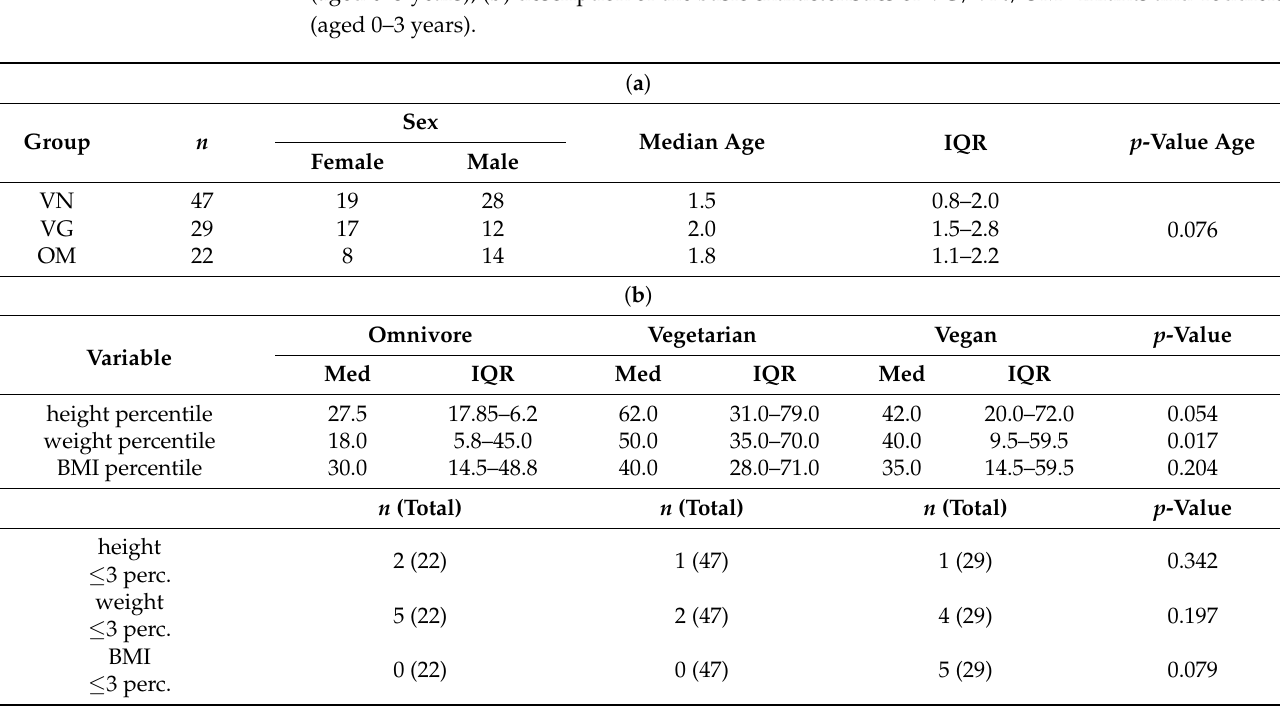
Table 4. ( a ) Description of the basic characteristics of VG/VN/OM “Infants and Toddlers” (aged 0–3 years); ( b ) description of the basic characteristics of VG/VN/OM “Infants and Toddlers” (aged 0–3